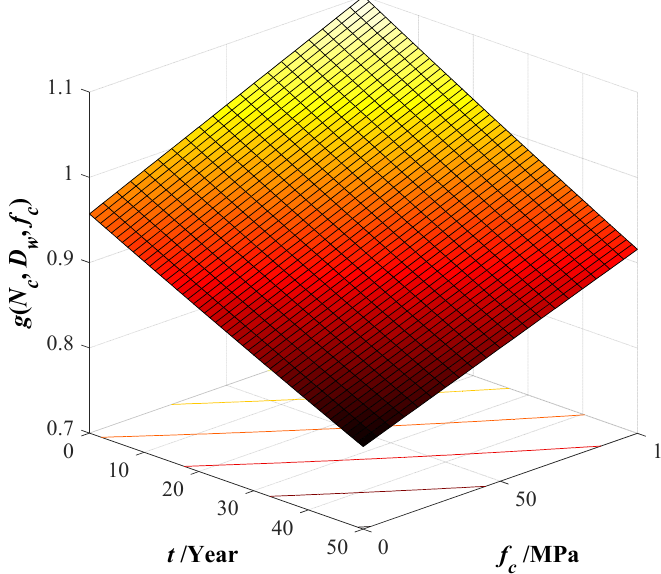
Figure 3. Dimensionless deterioration factor for the confined CFST.